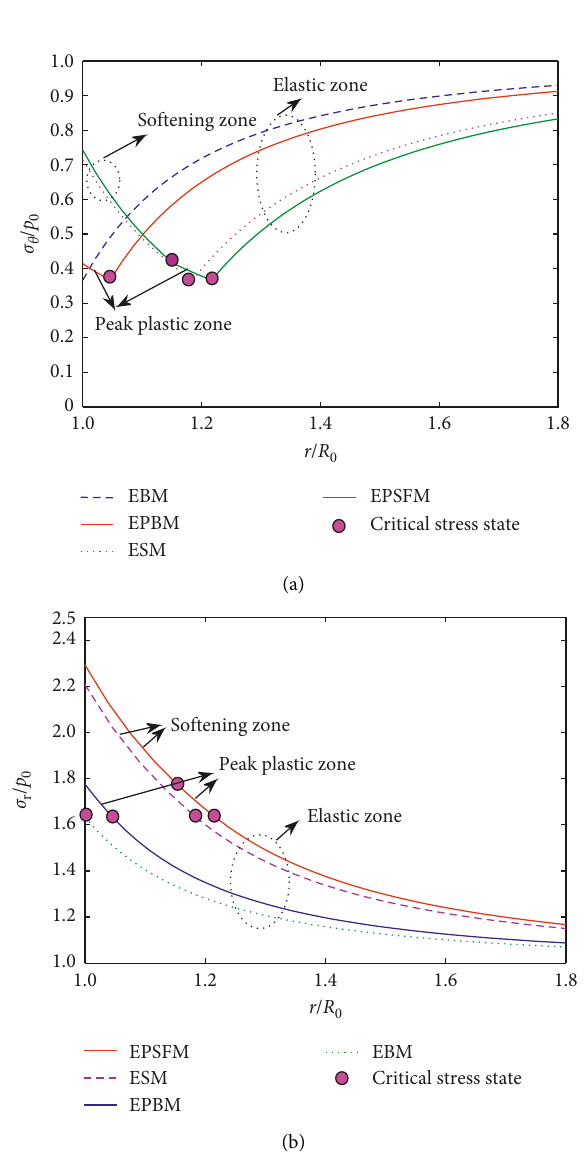
Figure 4: Stress distribution law for borehole expansion (note: because the maximum critical inner hydraulic pressure p exp max is taken as the calculated inner pressure, the fracture zone does not appear).